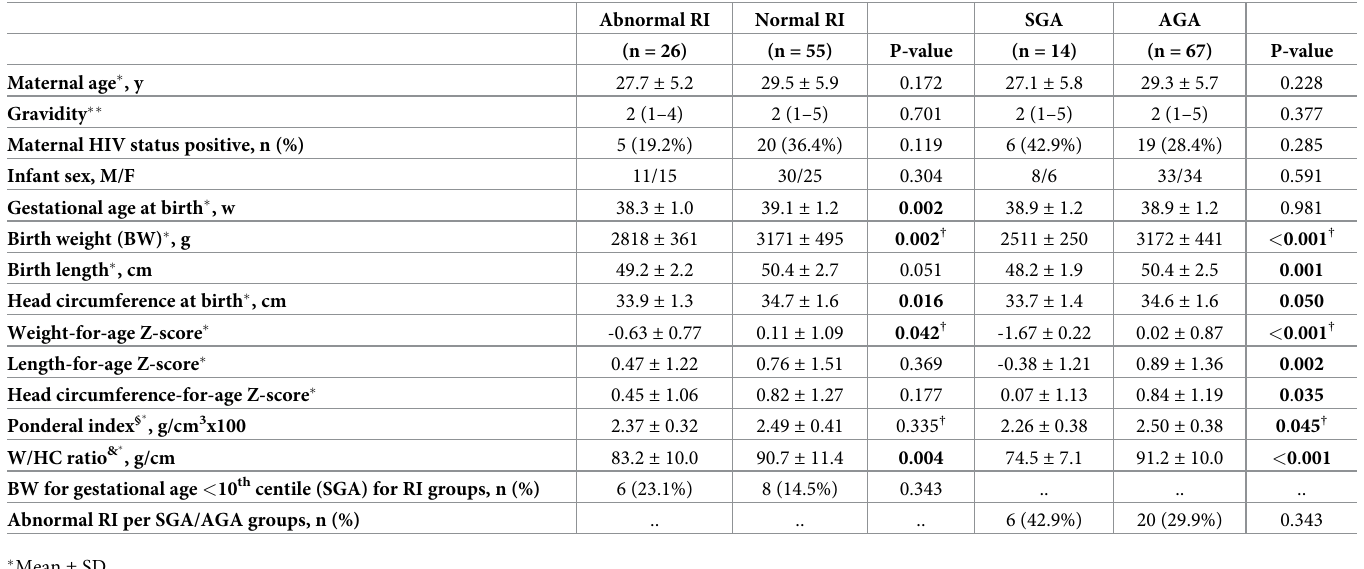
Table 1. Pregnancy and birth characteristics of the study participants, grouped by resistance index of the umbilical artery and by birth weight-for-gestational age categories.